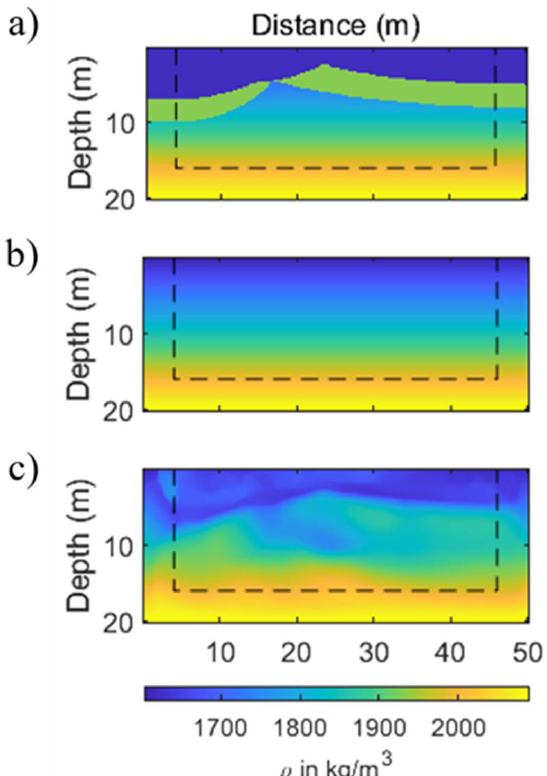
Figure 3. Multi-parameter synthetic example when using a low-frequency source signal: ( a ) the true density model for the calculation of the observed data, ( b ) the initial density model, and ( c ) the inverted density model. The CPML frame is marked by a thin black line.